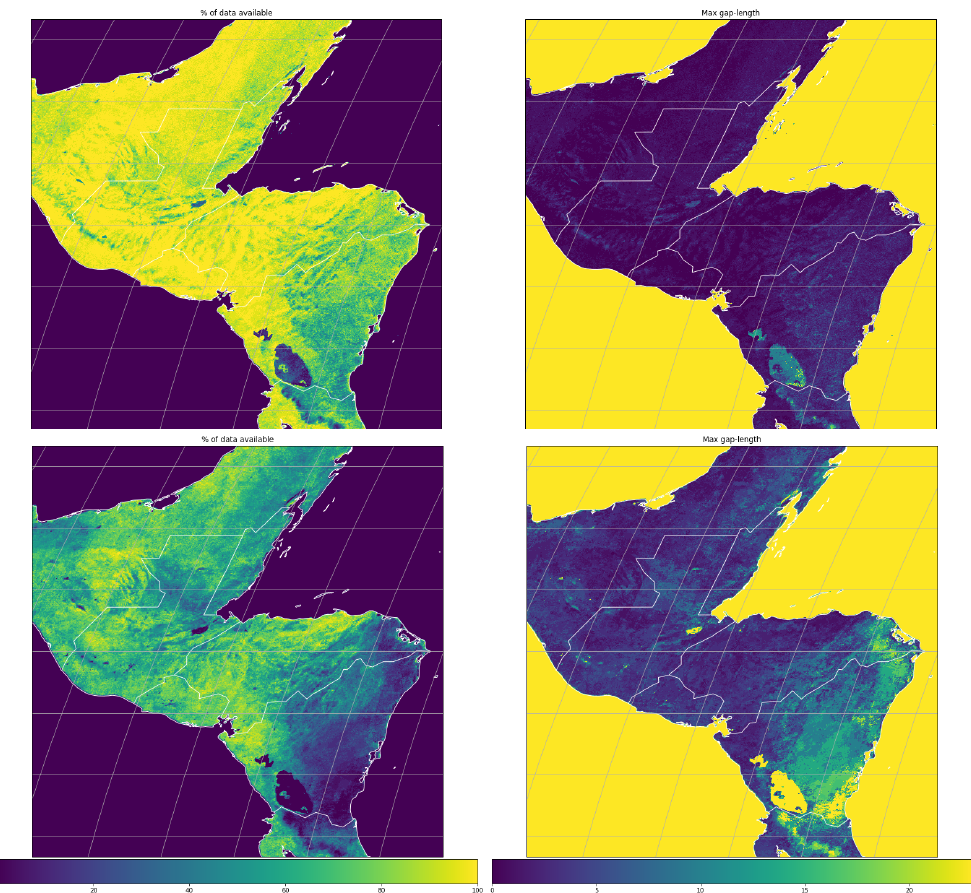
Figure 2. Metrics after applying two different quality assessment (QA) values for the MODLAND parameters on the “1_km_16_days_pixel_reliability” layer from the MOD13A2 product. The bottom panel shows the metrics for the “Good data, use with confidence” QA values, and the top panel shows the metrics for the more permissive “Marginal data. Useful but look at other QA information” QA values. The left column depicts the percentage of data available, and the right one, the maximum gap